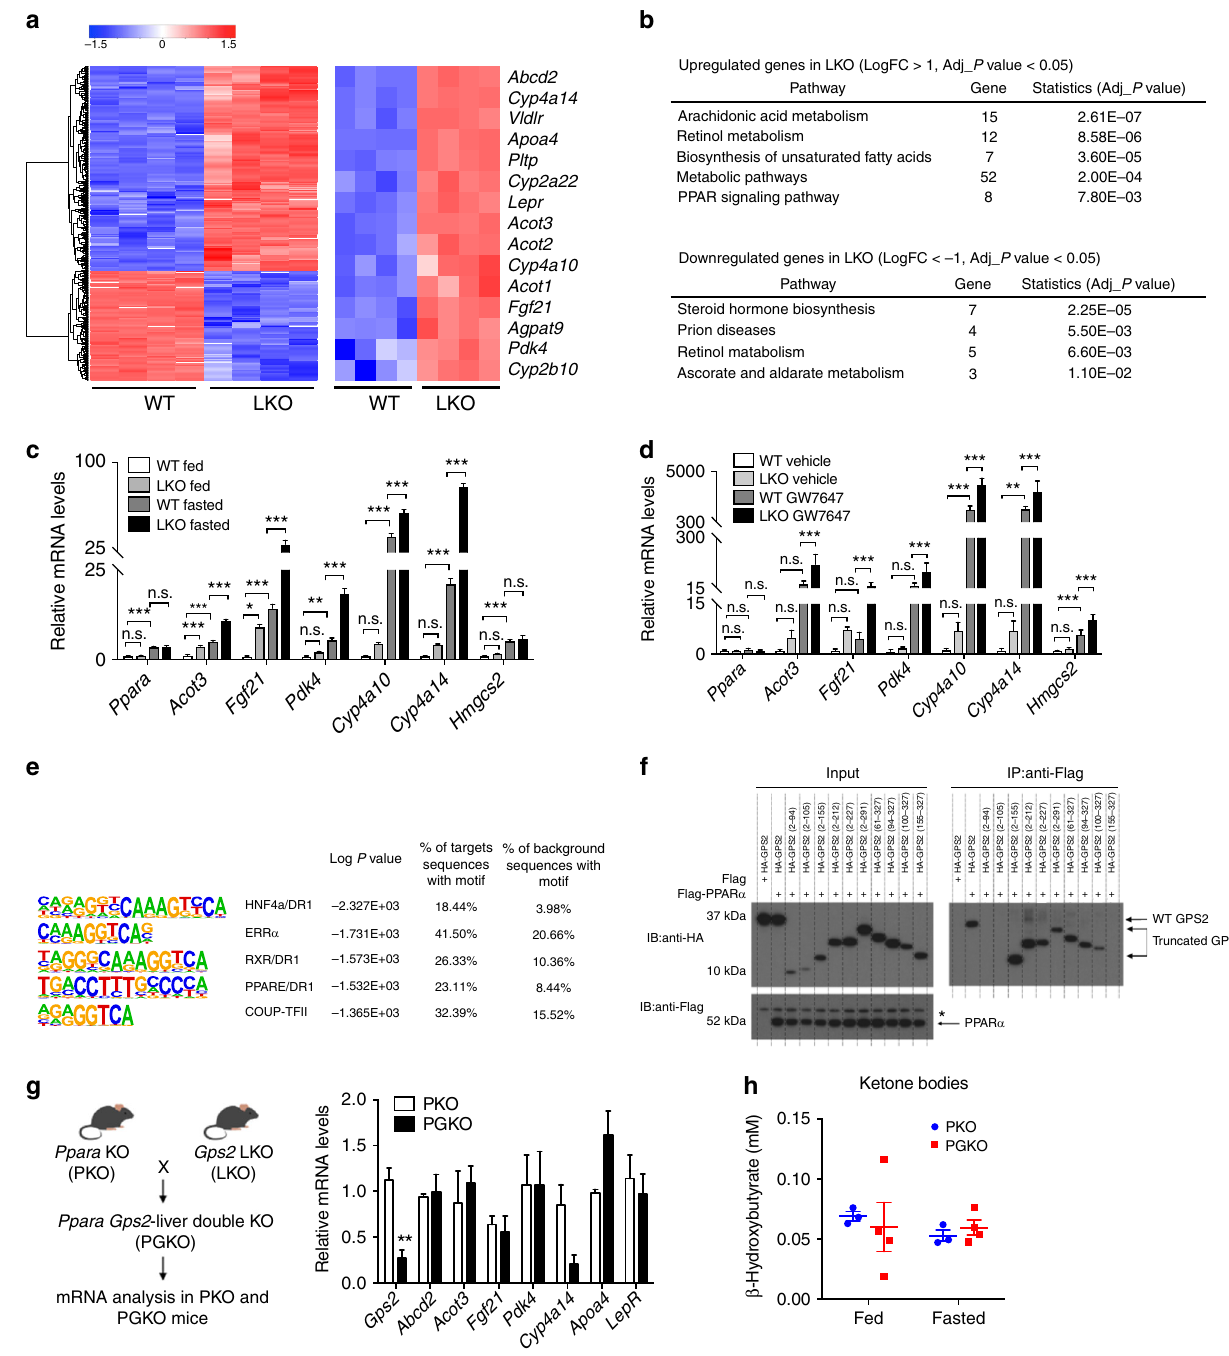
Fig. 3 GPS2 depletion causes PPAR α activation. a Heatmap representing the top 1000 signi fi cant (sorted based on adj P value) gene expression in CD-fed WT and LKO livers. b KEGG pathway analysis of signi fi cantly up-regulated and down-regulated genes in LKO mice. c , d QPCR analysis of mRNA expression in WT and LKO mice upon ( c ) fasting, n = 5 in each group; and ( d ) PPAR α agonist (GW7647) treatment, n = 5 in the vehicle groups, n = 7 in the GW7647-treated groups, one-way ANOVA followed by Tukey ’ s test. e Motif analysis of GPS2-occupied regions in mouse liver. f Co-immunoprecipitation of GPS2 domains with PPAR α in 293 cells (* represents non-speci fi c bands). g QPCR analysis of GPS2-regulated genes and ( h ) fed and fasted serum ketone bodies in PPAR α KO (PKO) and liver Gps2 / Ppar α double KO (PGKO) mice livers, n = 3 in PKO and n = 4 in PGKO, non-parametric Mann – Whitney test. All data are represented as mean ± s.e.m. * P < 0.05, ** P < 0.01, *** P <